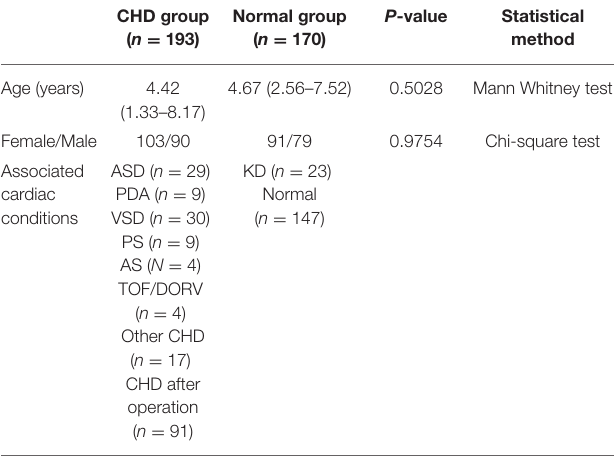
TABLE 2 | Characteristics comparison between the CHD group and the normal groups of the test data set. CHD group ( n =